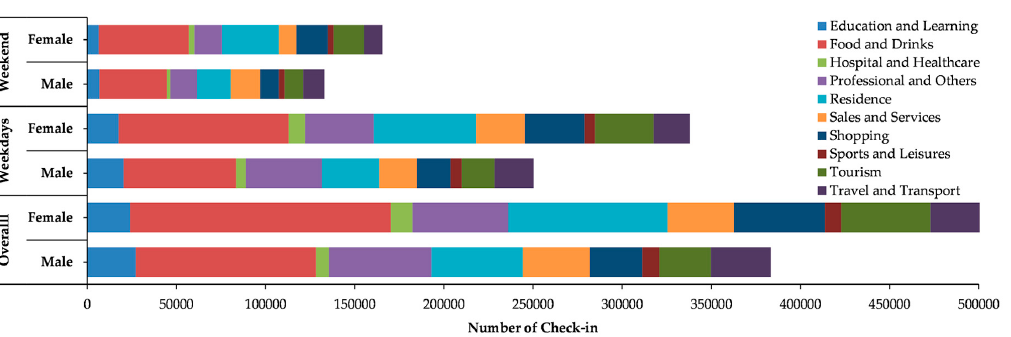
Figure 7. Sex-based check-in distribution of activities in Shanghai.